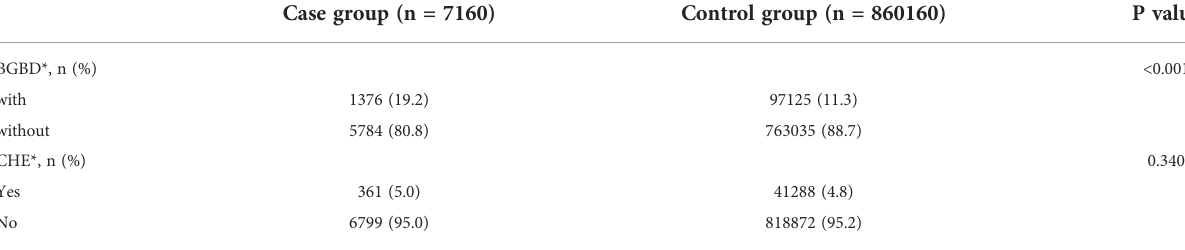
TABLE 1 Incidence of BGBD and CHE between colorectal cancer patients and health examination